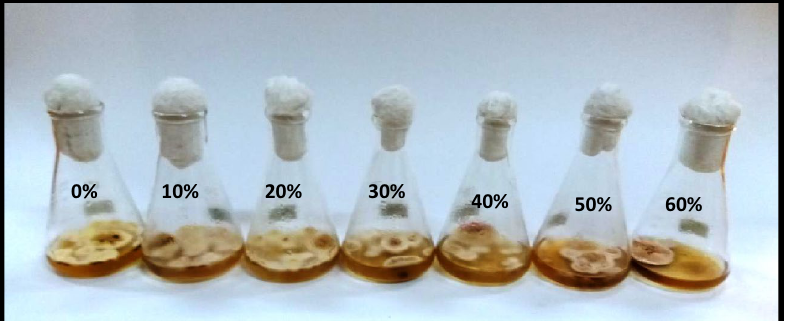
Figure 7. Effect of metabolite concentrations of P. crustosum on the growth of P. herbarum.